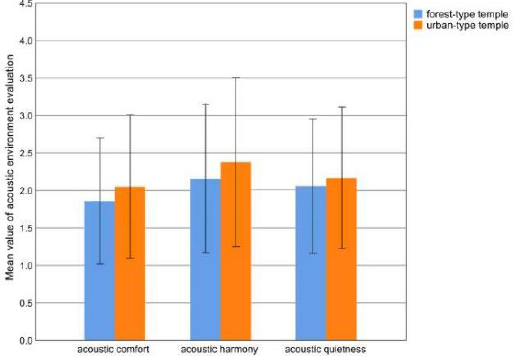
Figure 2. The evaluation value and standard deviation of the acoustic environment in forest-type and urban-type temples. Table 3. Correlation between the subjective evaluation of the acoustic environment in the temple.